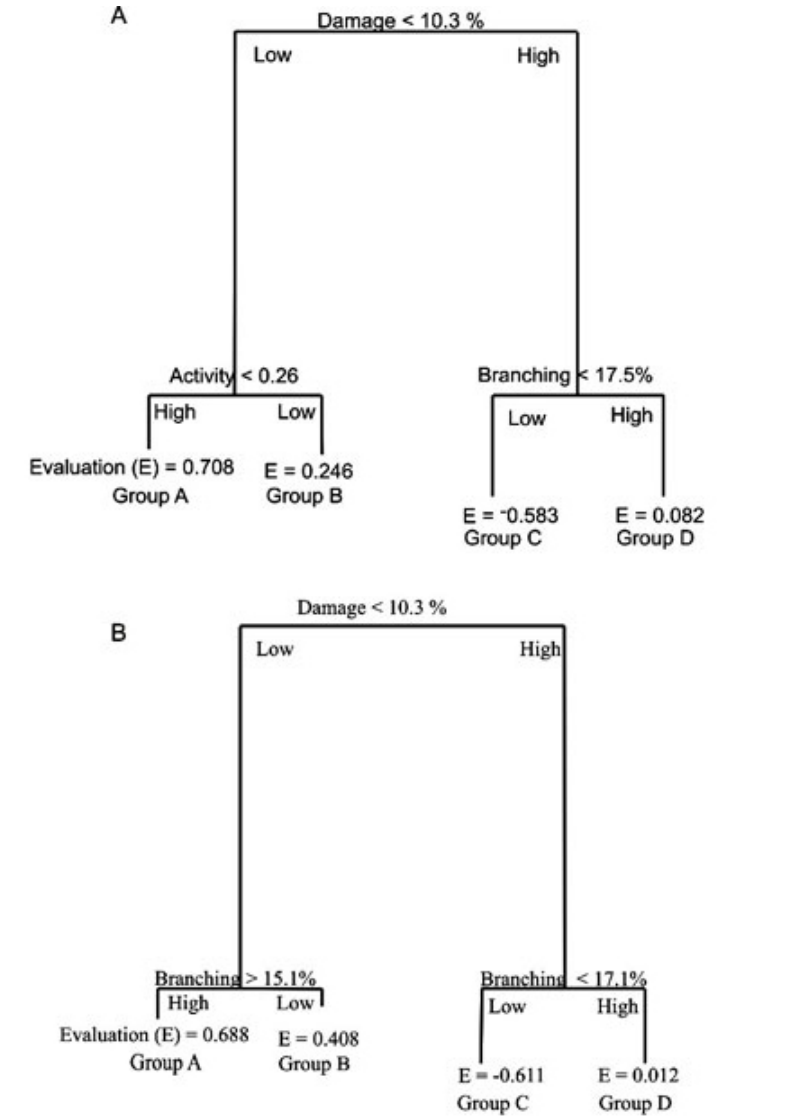
Fig. 6 . The relationship of the evaluation dimension to the five ecological measures and the two subjective descriptions provided by the regression tree analysis for participants who had a working association with coral reefs (A) and those who did not (B). The values of the predicted variables for the ecological measures provided on the tree are the percent cover and, for the perceptual meanings, the value from the component matrix. The regression tree analysis determined four groups of photographs (A, B, C, and D), and the mean evaluation score (E) for each group is